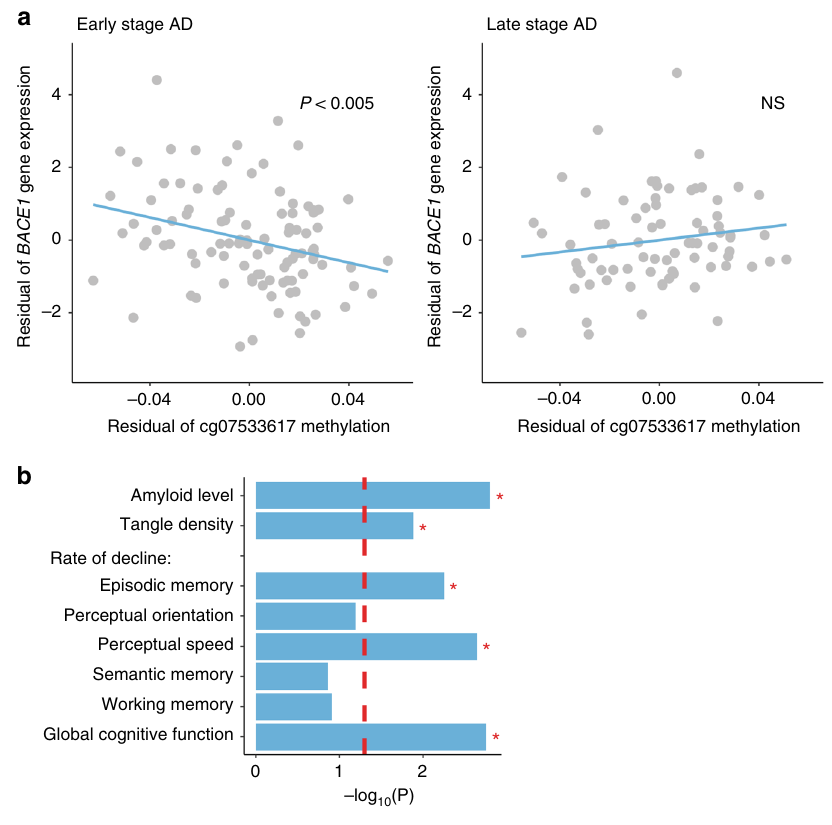
Fig. 4 DNA methylation at DSCAML1 intron 3 is linked to BACE1 gene expression and to the pathology and cognitive symptoms of AD. a Correlation of DNA methylation at a DSCAML1 CpG site (cg07533617) with BACE1 mRNA expression in the AD prefrontal cortex. DNA methylation status at cg07533617 (situated in DSCAML1 intron 3 at an enhancer interacting with the BACE1 gene promoter) was inversely correlated with BACE1 mRNA expression during the early stages of AD (Braak stage ≤ 4, n = 101 AD patients; p < 0.005, robust linear regression) but not in late stage (Braak stage ≥ 5, n = 76 AD patients; p = 0.21, robust linear regression). Analysis performed using the ROSMAP dataset, which contained both transcriptomic data generated by RNA-seq and genome-wide DNA methylation data generated by 450K Illumina DNA methylation arrays from the same AD patients. Correlation between residuals of DNA methylation (beta values of probe cg07533617, x -axis) and BACE1 mRNA levels (FPKM, y -axis) shown. b Signi fi cance of correlation between DNA methylation at cg07533617 in DSCAML1 intron 3 and AD pathology/cognitive symptoms; determined using ROSMAP DNA methylation and pathological/ clinical data ( n = 465 AD and controls; 251 AD and 214 controls). DNA hypomethylation at cg07533617 in DSCAML1 intron 3 was signi fi cantly correlated with increased amyloid pathology and neuro fi brillary tangle density, as well as a decline in episodic memory, perceptual speed, and global